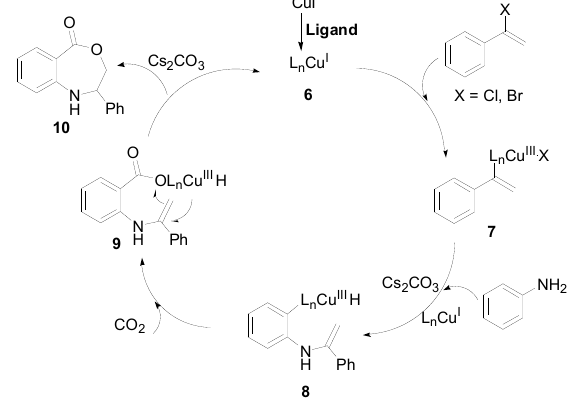
Scheme 2. A plausible mechanism of the catalytic